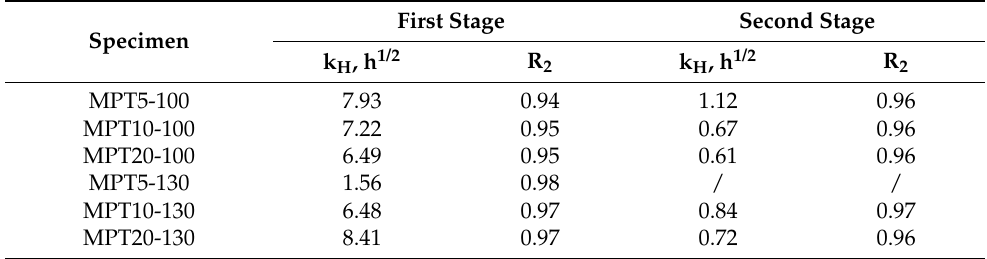
Table A3. Higuchi dissolution constants, k H , and correlation coefficients, R 2 , of PCL/MPT